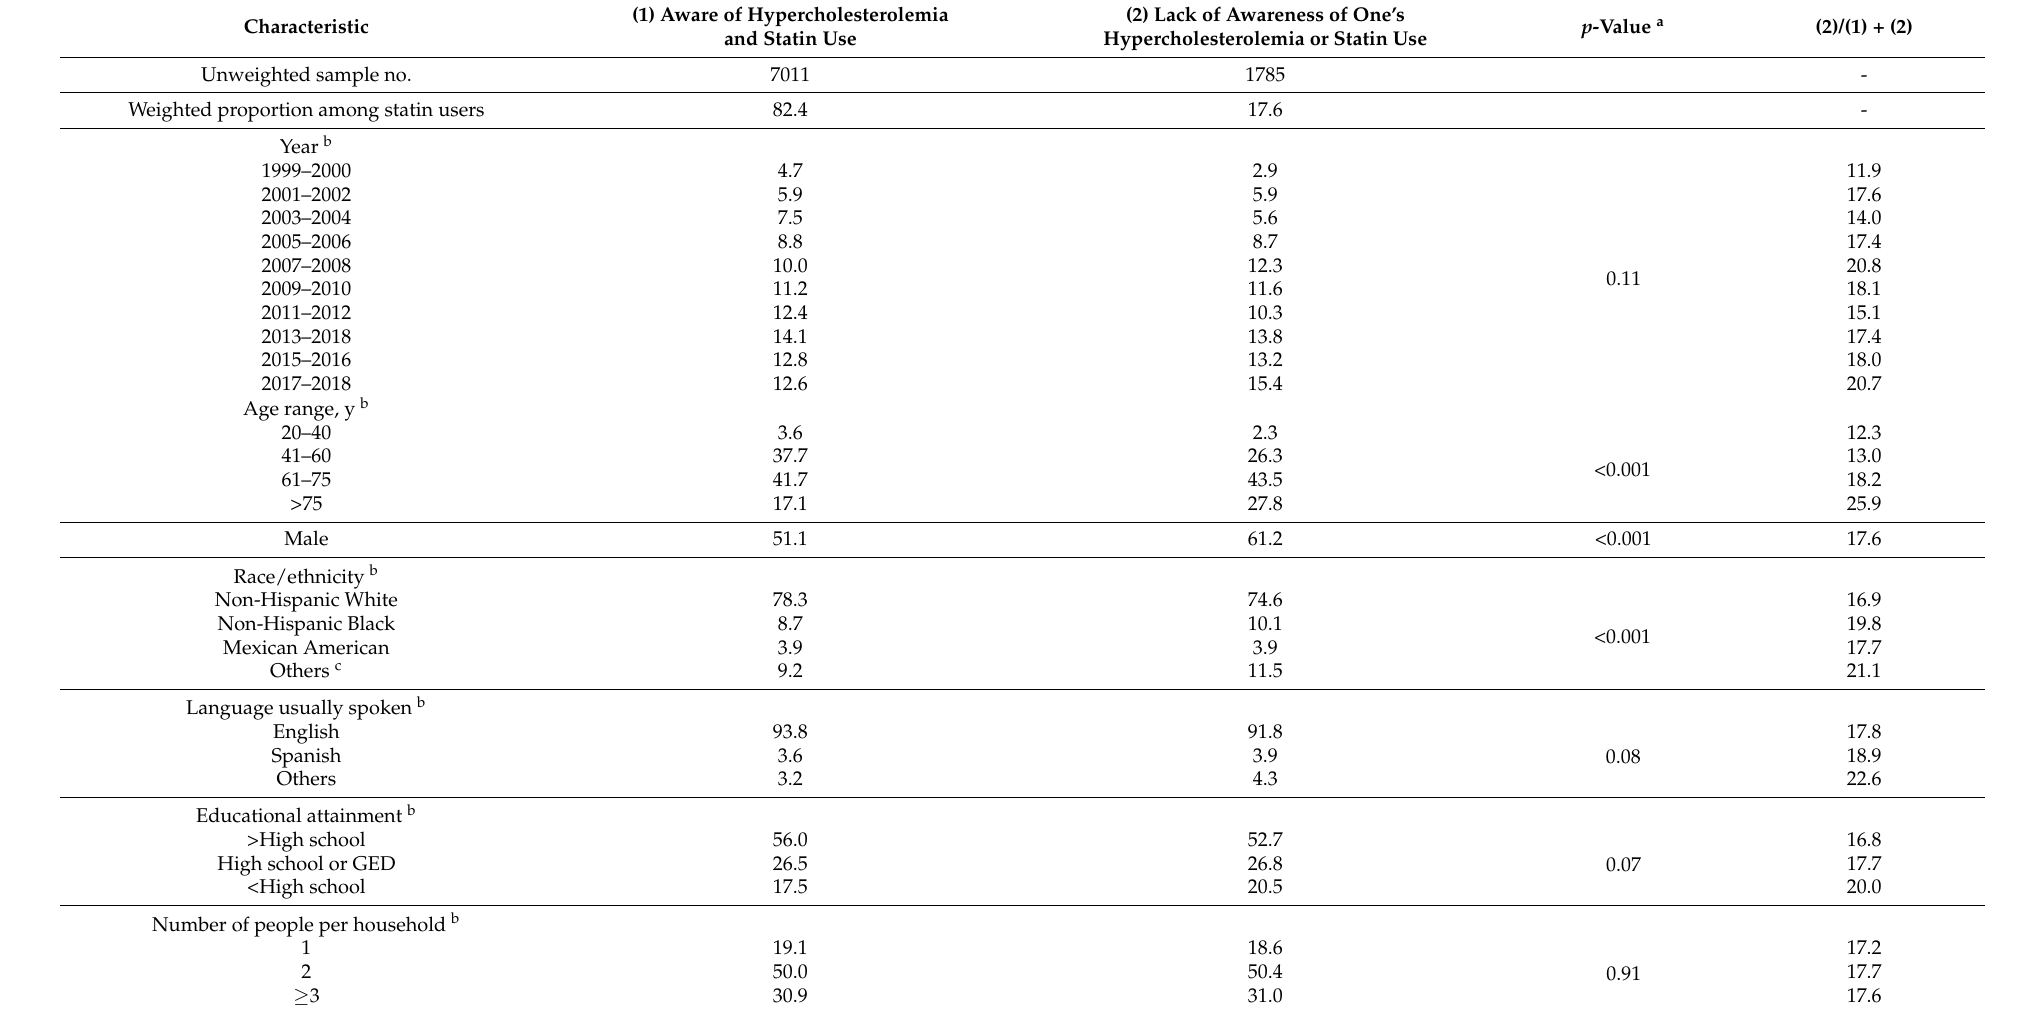
Table 2. Characteristics of the study sample by awareness of one’s hypercholesterolemia status or statin